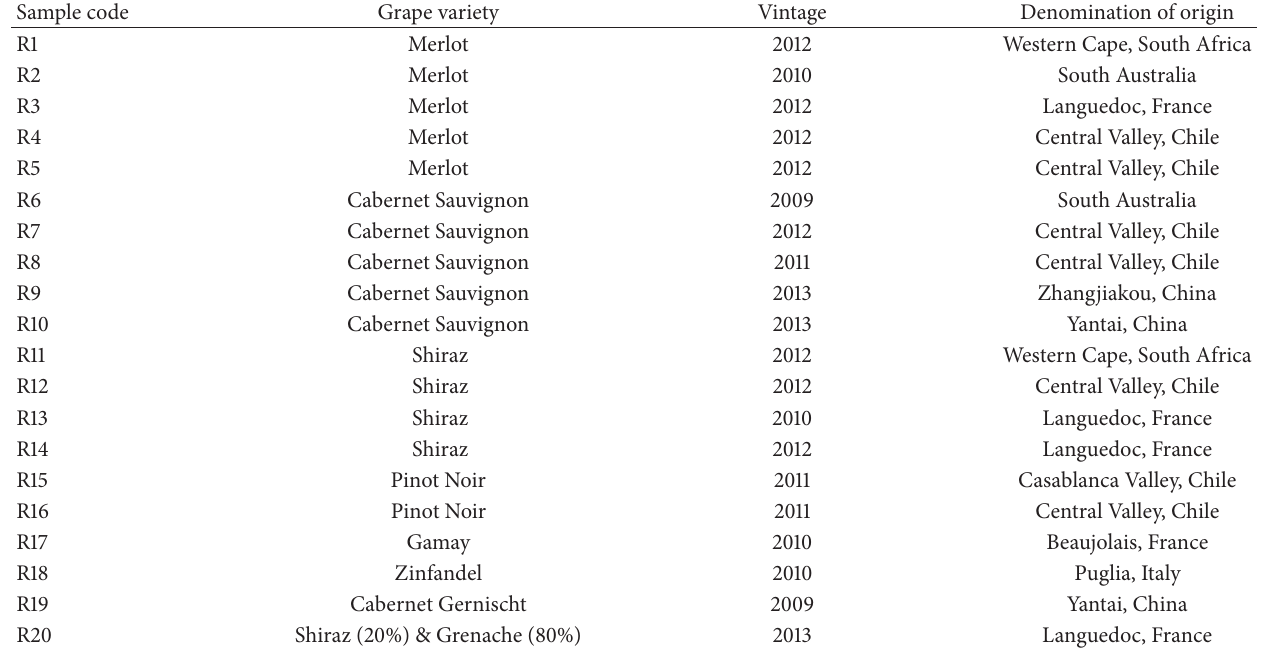
Table 1: Detailed information of the investigated red